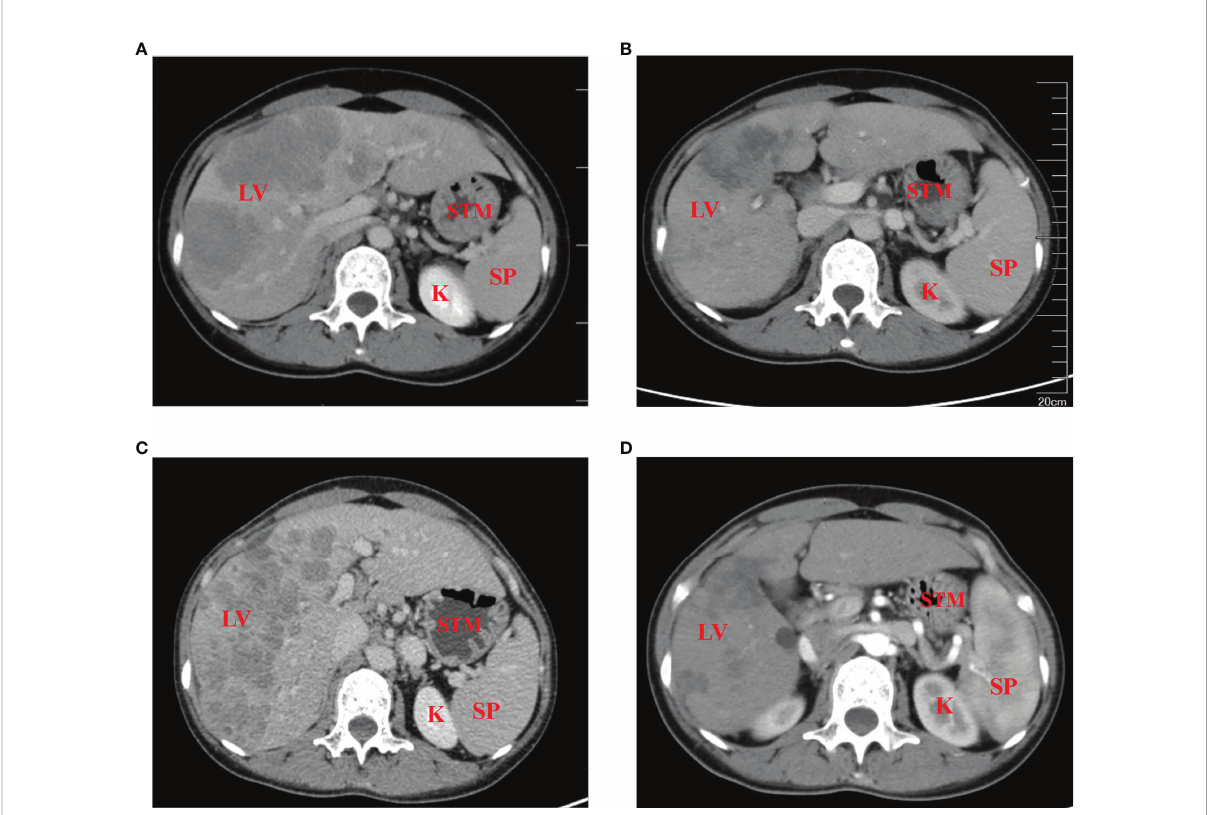
FIGURE 1 Contrast-enhanced CT scans of the patient (A) prior to, and (B) 5 months after the initiation of therapy. (C) At 6 months post-diagnosis, the curative effect was evaluated as progressive disease, with no effect of third-line therapy of Tislelizumab combined with Apatinib. (D) The disease returned to partial remission after treatment with the fourth-line treatment. LV, liver; STM, stomach; SP, spleen; K,